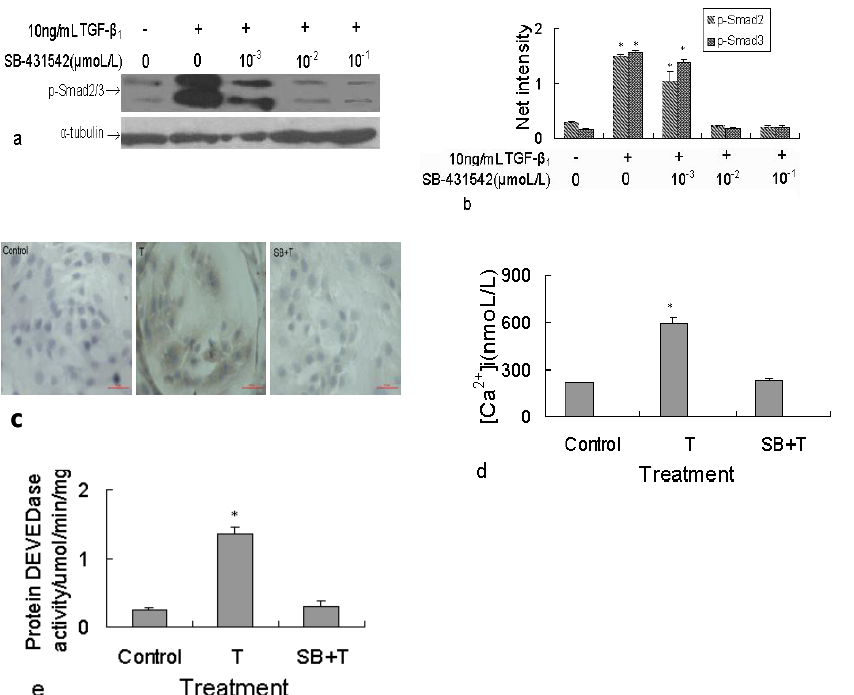
Figure 5. The variation of phosphorylation of Smad2/3, concentration of Ca 2+ and activity of Caspace-3 in mammary epithelial cells treated with SB-431542. (a) The express changes of p-Smad2/3 treated with SB-431542 at varied concentration (0, 10 -3 , 10 -2 and 10 -1  M) for 1 h, then treated with 10 ng/ml of TGF-  1 for 2 h. (b) The expression changes of p-Smad2/3 treated with SB-431542. (c) The expression changes of p-Smad2/3 of different treatments: control, TGF-  1 2 h treatment, SB+TGF-  1 2 h treatment. (d) The intracellular Ca 2+ of different treatments: control, TGF-  1 6 h treatment, SB+TGF-  1 6 h treatment. (e) The activity of Capase-3 of different treatments: control, TGF-  1 12 h treatment, SB+TGF-  1 12 h treatment. * Indicates a significant difference between two groups